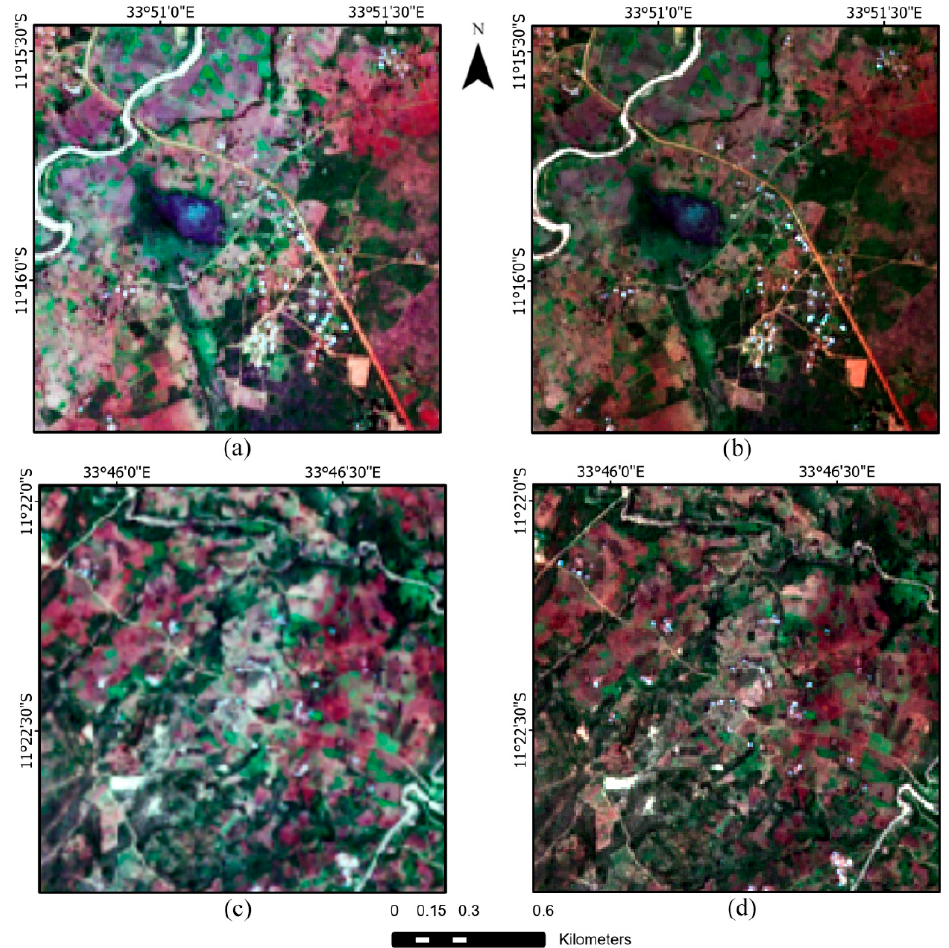
Figure 5. True color composites of the subset images from ( a ) Sentinel-2 image for Thimalala on 07/01/2020; ( b ) fused images for Thimalala; ( c ) Sentinel-2 images for Edundu on 07/01/2020; ( d ) fused images for Edundu.